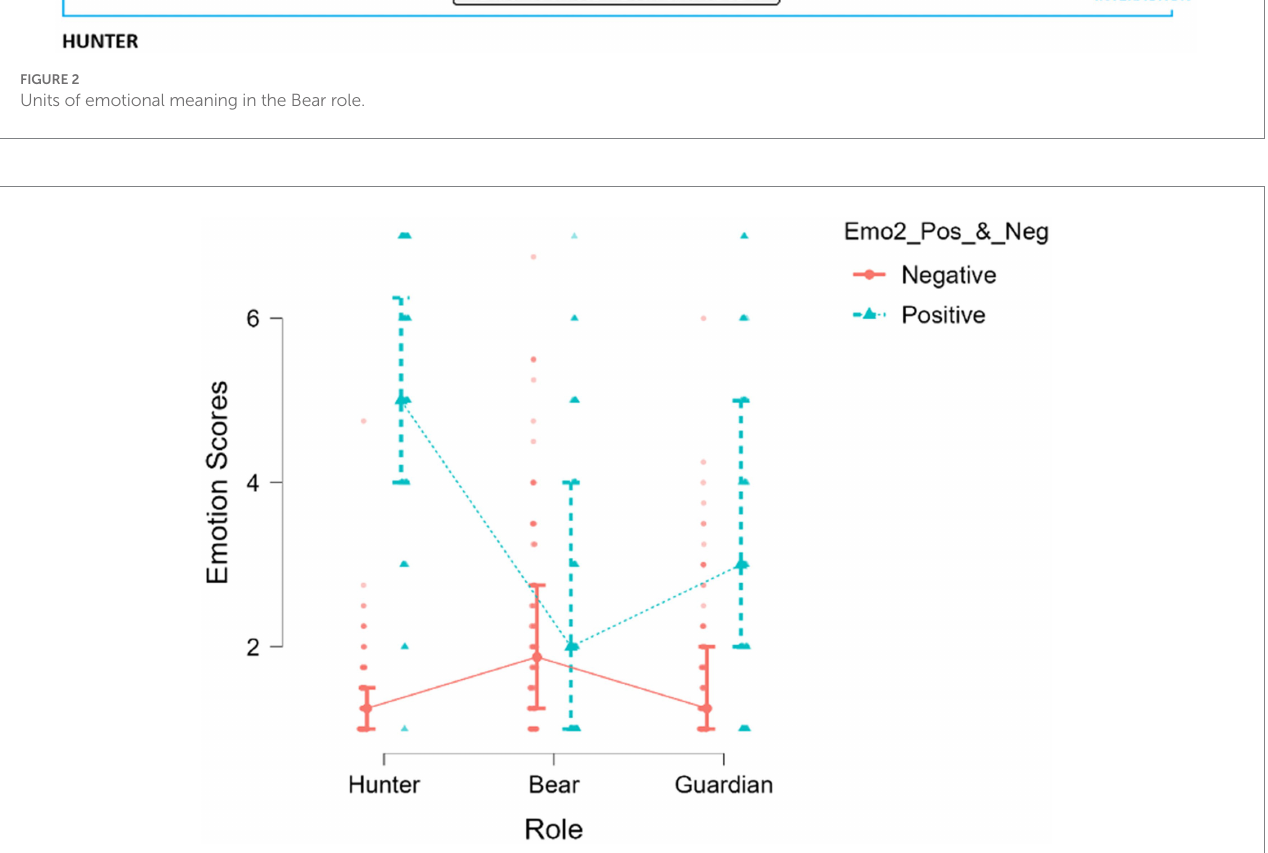
FIGURE 3 Units of emotional meaning in the Guardian